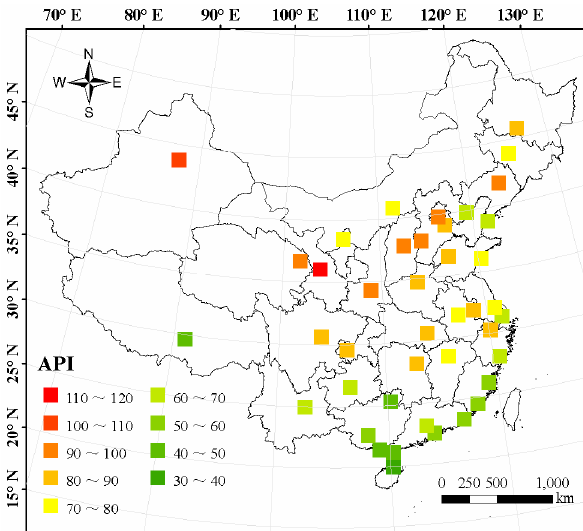
Fig. 5. Spatial distribution of average daily API (Air Pollution Index) over 42 cities across China for 2001–2011.